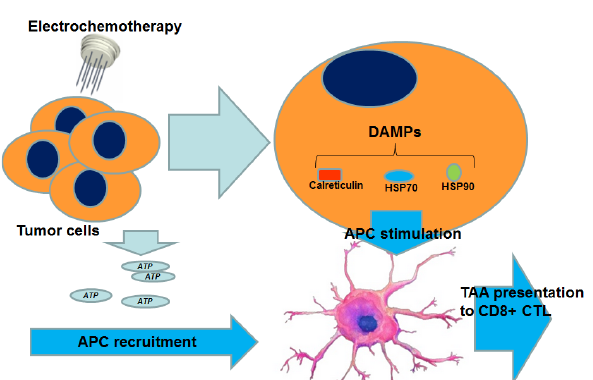
Figure 2. Mechanisms through which ECT may boost the immune response. APC can be stimulated directly through the release of ATP by tumor cells and also indirectly, through the intra-cellular production of DAMPs. (ATP: adenosine triphosphate; DAMPs: damage associated molecular pathways; APC: antigens presenting cell; CTL: cytotoxic